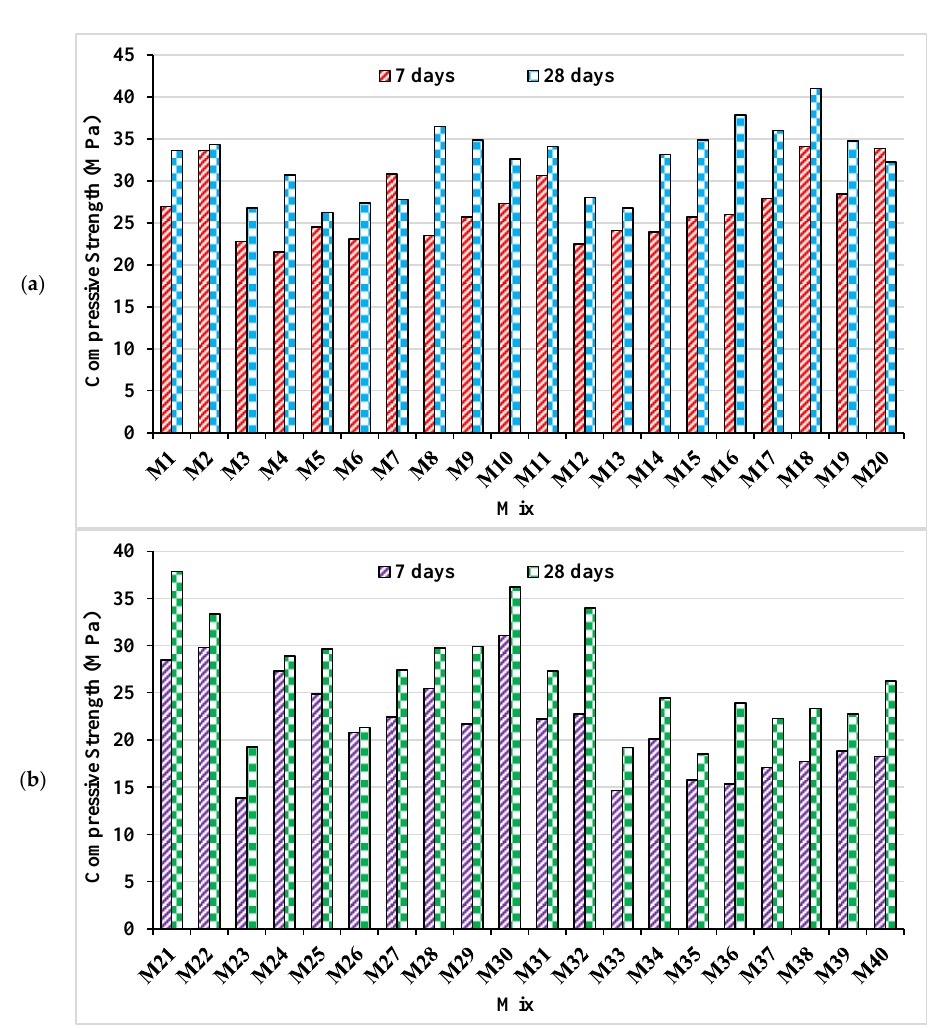
Figure 9. Experimental compressive strength; ( a ) plain concrete; ( b ) marble powder concrete.